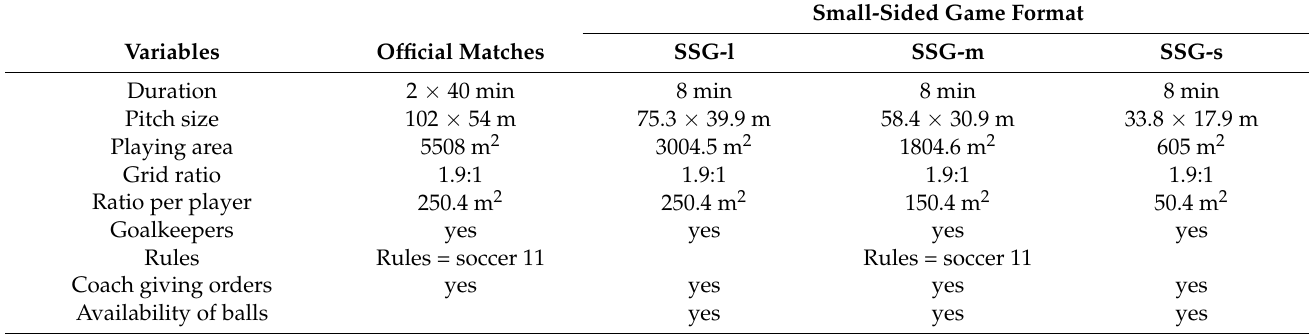
Table 1. Established characteristics of the three small-sided game formats (SSG-l = large, SSG-m = medium, SSG-s = small) and official